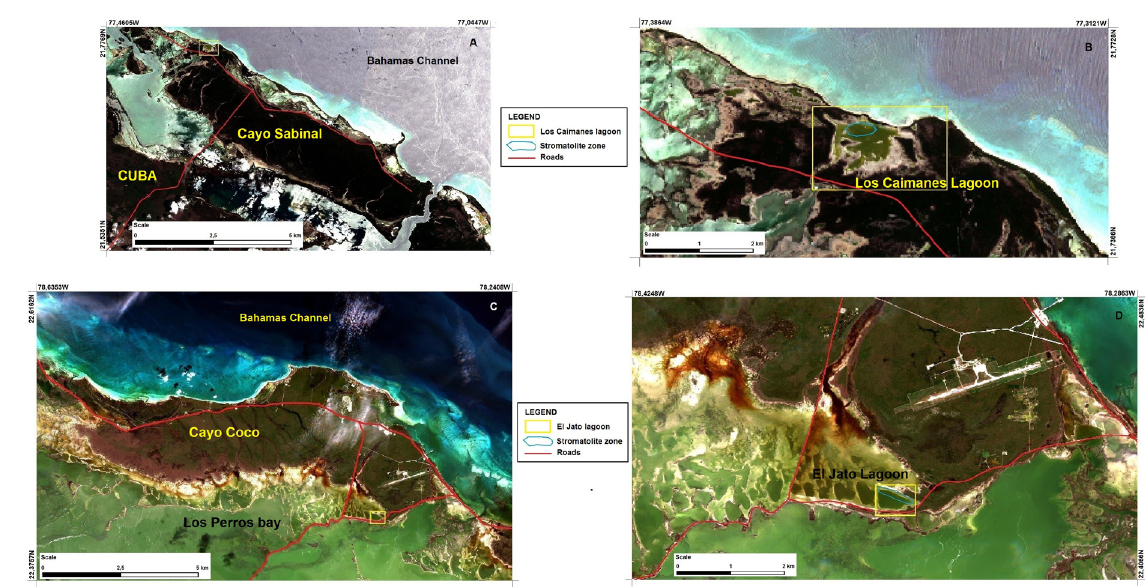
Figure 3. Aerial images of Cayo Sabinal (A), Los Caimanes Lagoon (B), Cayo Coco (C), and El Jato Lagoon